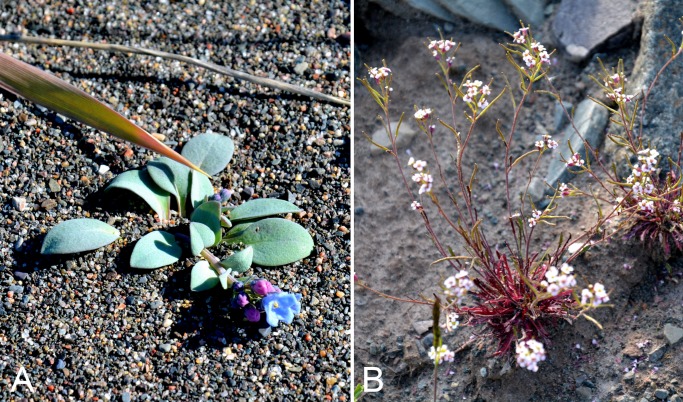
Mertensia maritima subsp. tenella and Braya humilis subsp. humilis.Mertensia maritima subsp. tenella: (A) habit, Saarela et al. 3714. Braya humilis subsp. humilis: (B) habit, Saarela et al. 3965. Photographs by P. C. Sokoloff.